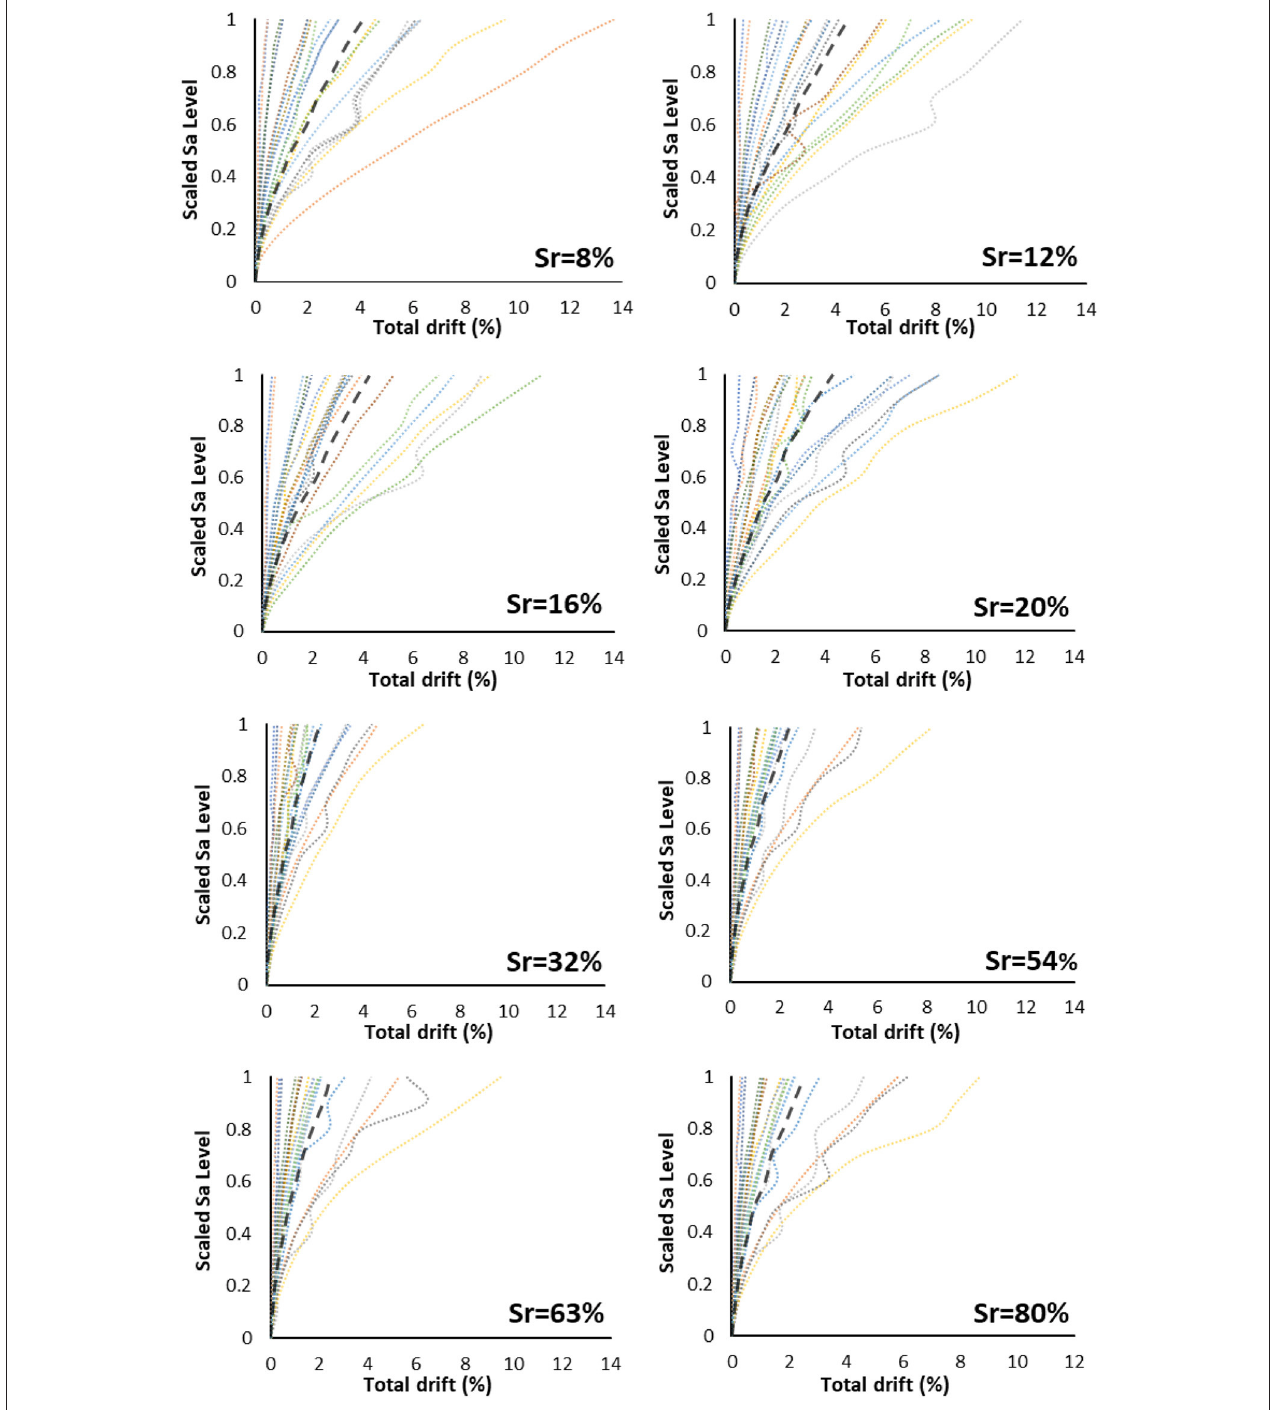
FIGURE 7 | Total drift MSDA curves for the building in its initial state, in which dashed curves show median values.